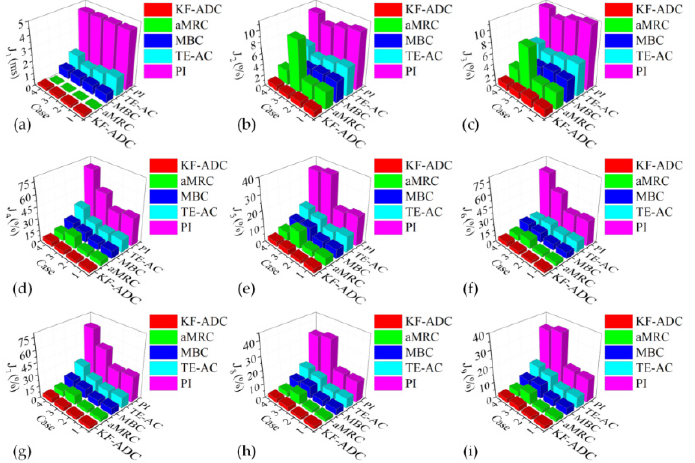
Figure 13. Comparison with other methods. ( a ) J 1 ; ( b ) J 2 ; ( c ) J 3 ; ( d ) J 4 ; ( e ) J 5 ; ( f ) J 6 ; ( g ) J 7 ; ( h ) J 8 ; ( i ) J 9 .